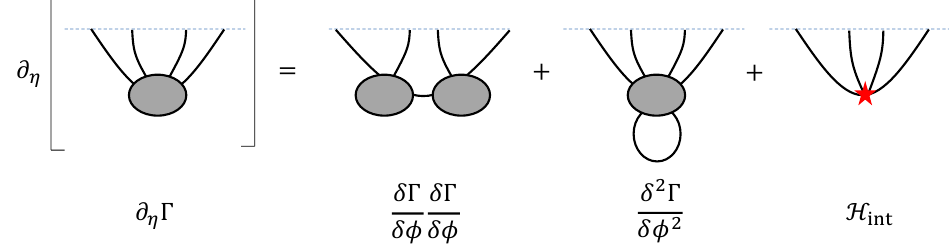
Figure 2 . The Hamilton-Jacobi equations for the wavefunction phase, Γ . The time derivative is given by all possible ways of splitting the interaction into two pieces (exchange contribution), plus all possible ways of contracting a single higher-point coefficient into a loop (loop contribution), plus any interactions in the Hamiltonian (contact